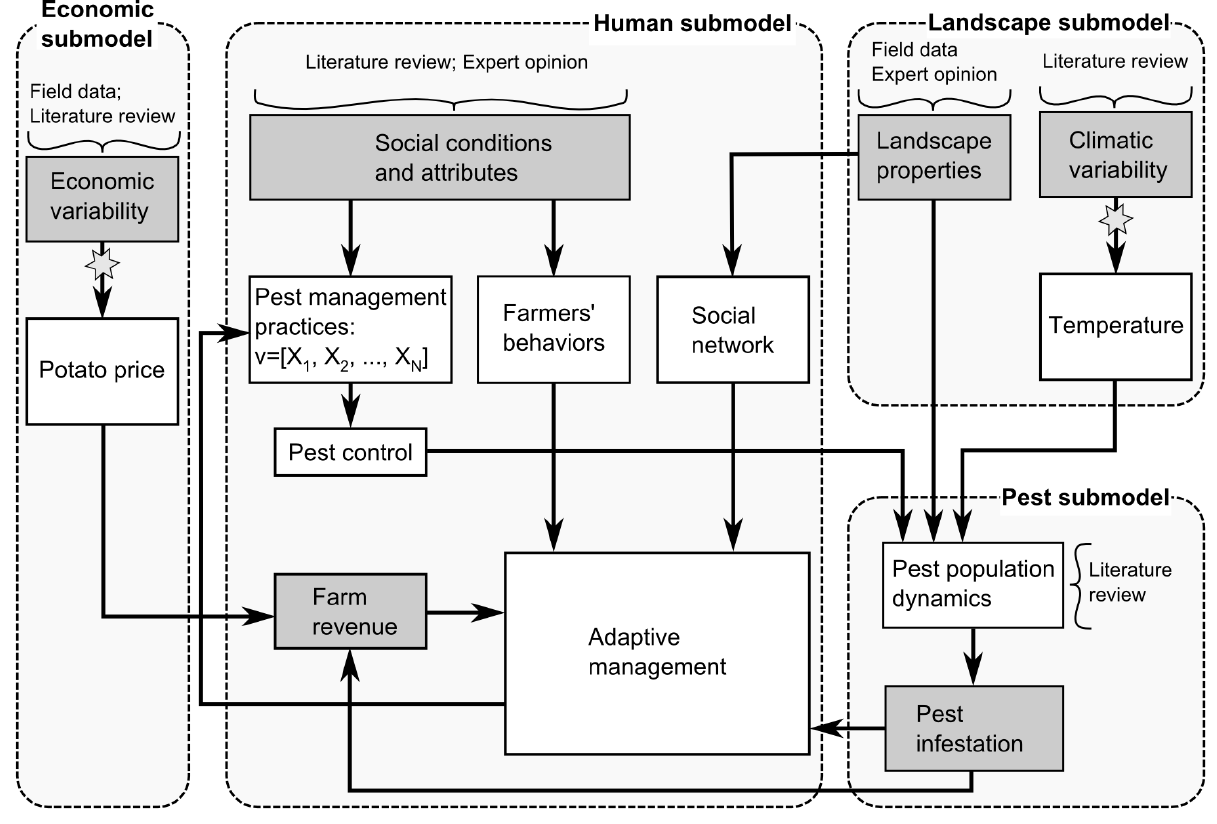
Fig. 1 . Representation of the model structure (nonformal graphics). The underlying model is composed of a network of interacting farmers who are capable of learning and adapting to circumstances. They work on farms that are facing the impact of an agricultural pest that evolves. The model includes (1) a landscape submodel, which represents the landscape characteristics and climatic condition, (2) an economic submodel that generates the potato price, (3) a pest submodel, which simulates the pest population dynamics, and (4) a human submodel, which represents farmers who are dealing with the pest and using adaptive management. The grey boxes represent input and output variables and grey stars the analyzed input variables (temperature variability and potato price